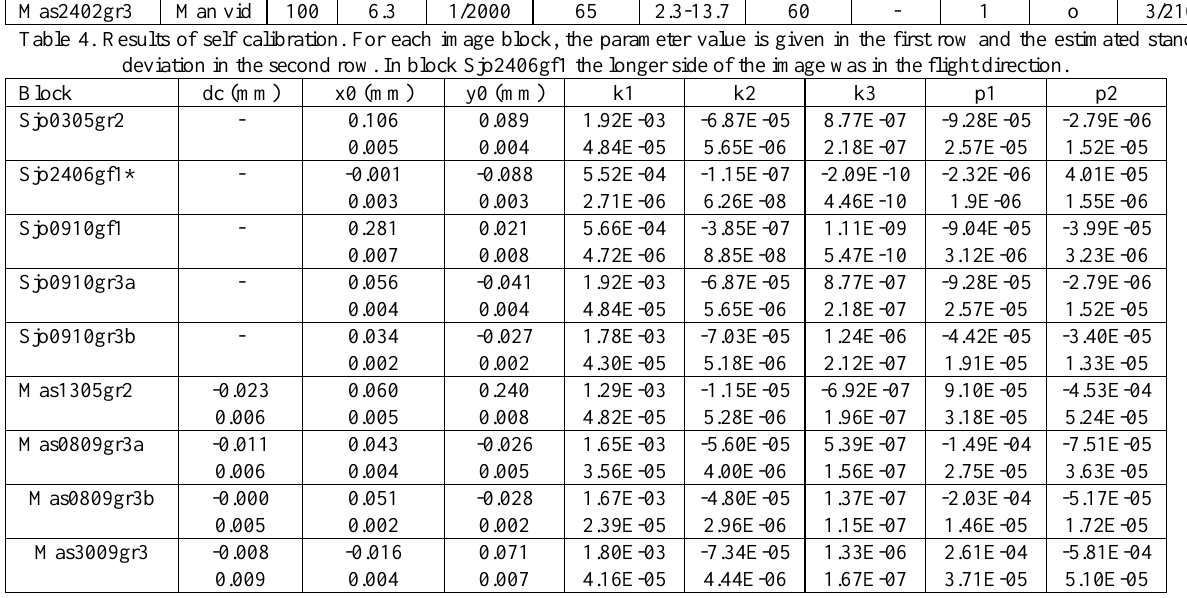
Table 4. Results of self calibration. For each image block, the parameter value is given in the first row and the estimated standard deviation in the second row. In block Sjo2406gf1 the longer side of the image was in the flight direction.